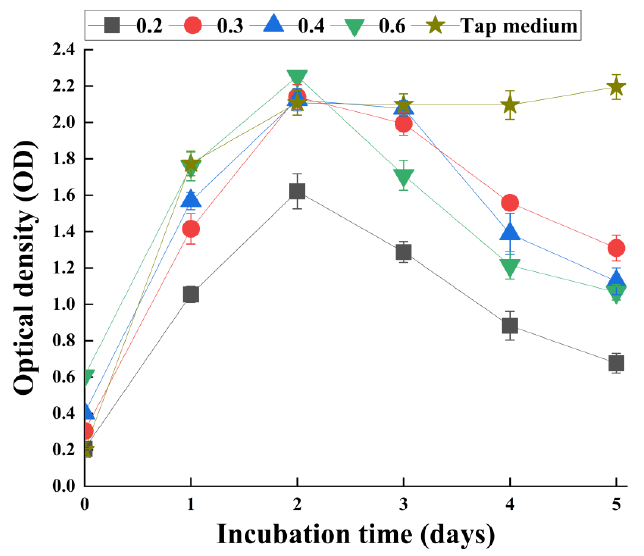
Figure 6. Growth curves of NCU-39 at different initial optical densities (ODs) (OD values = 0.2, 0.3, 0.4, and 0.6) in 5-fold diluted anaerobic digestion piggery effluents (ADPEs) pretreated by 3-day fungal decolorization. Tap medium was used as a control. Error bars represent standard deviations ( n =